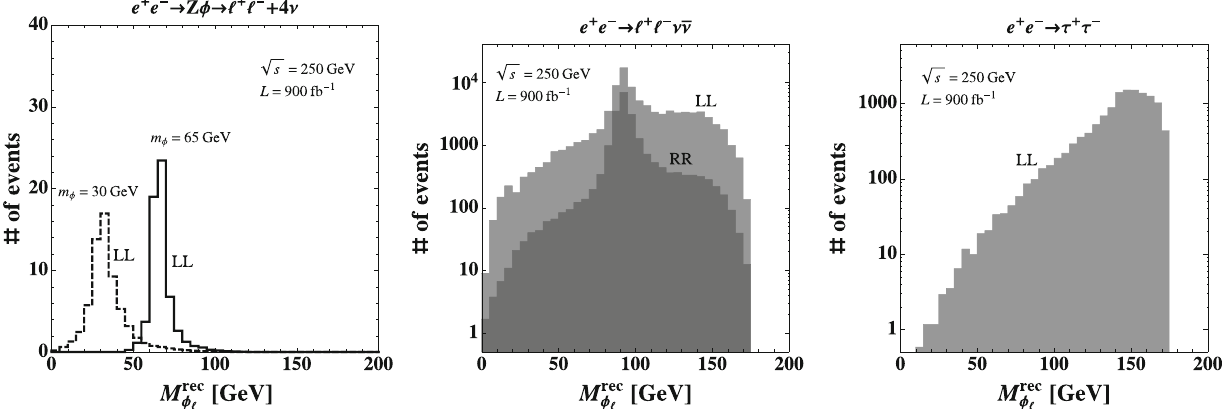
Fig. 7 Distribution of reconstructed ϕ mass after imposing basic and M (cid:18) + (cid:18) − cuts where left-, middle- and right-panels correspond to signal, (cid:18) + (cid:18) − ν ¯ ν BG and τ + τ − BG events. Here κ α = 1 is applied Table 2 The number of events for signal ( N S ), BG ( N BG ) and sig- nificance ( S cl ) for RR polarization case after each cut where we have adopted m φ = ( 30 , 65 ) GeV as reference values. The integrated lumi-